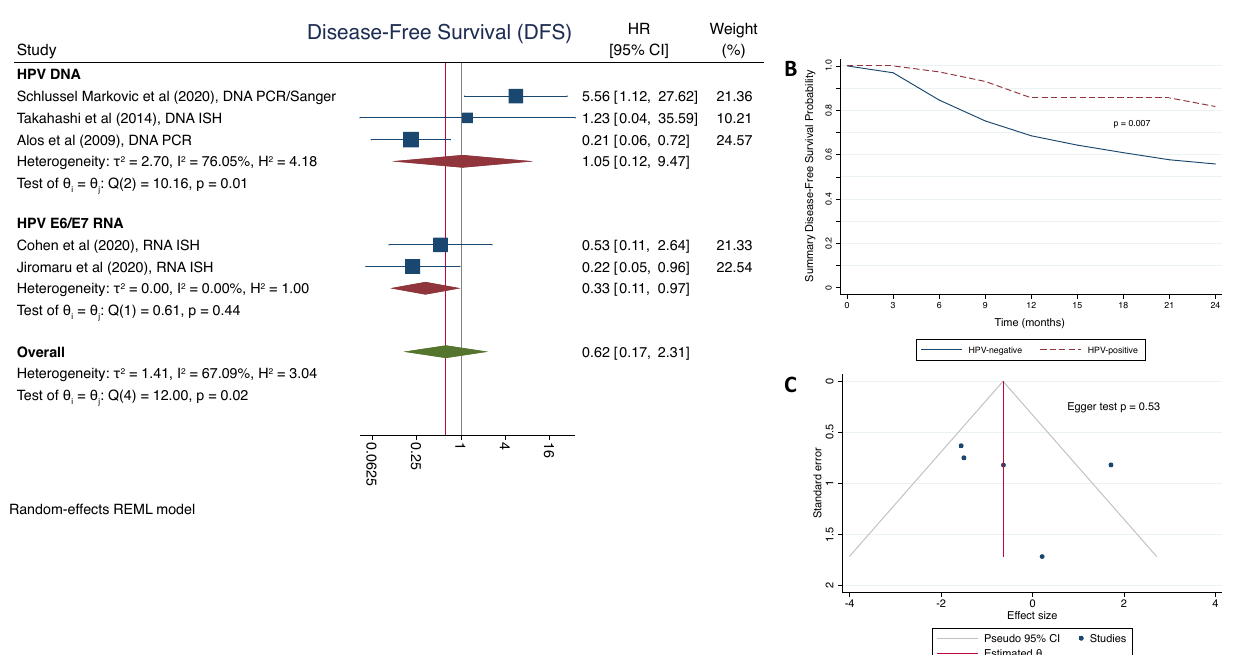
Figure 3. Summary estimates for the association between human papillomavirus (HPV)-status and disease-free survival (DFS) for patients with sinonasal squamous cell carcinoma (SNSCC): ( A ) forest plot of overall survival meta-analysis with summary hazard ration (HR) stratified by HPV detection method; ( B ) summary Kaplan-Meier curve for 2-year DFS of SNSCC patients by HPV status with log-rank p-value for differences between curves; ( C ) funnel plot for Egger test to assess evidence bias due to small study